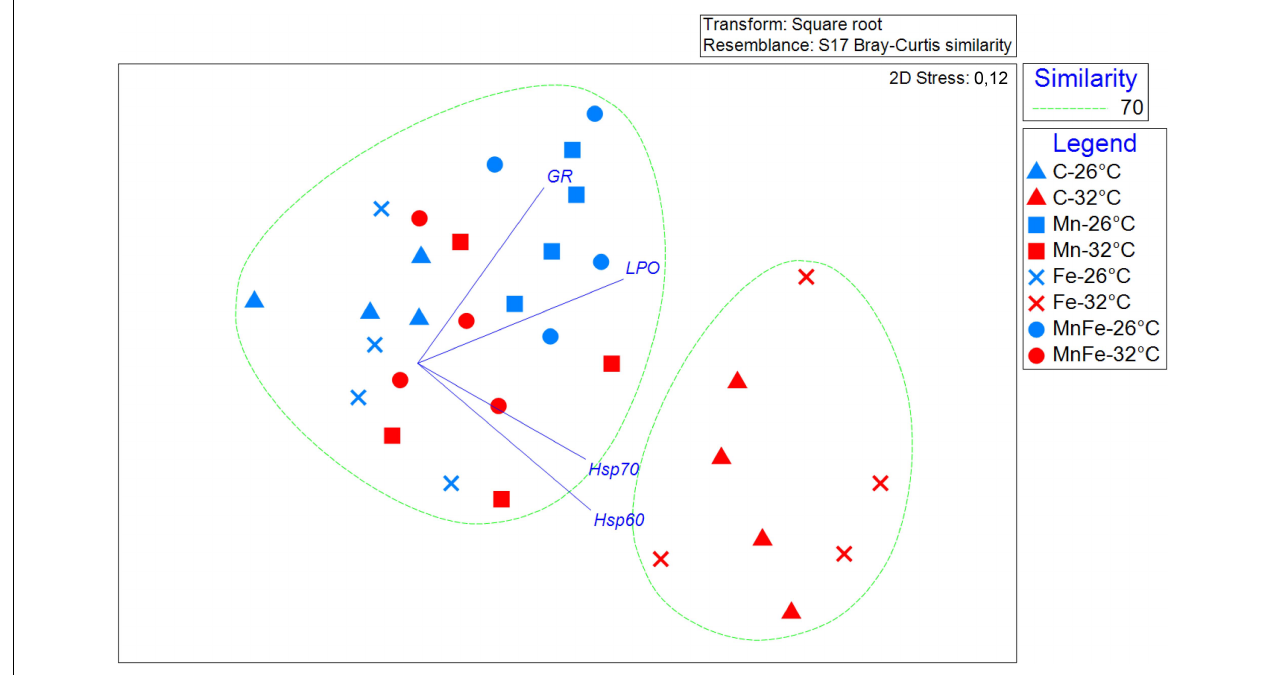
FIGURE 4 | Non-metric multidimensional scaling plot (nMDS) showing the response pattern of all the S. pistillata biomarkers analyzed by metal treatment and different temperatures, with vectors (Pearson’s correlations ≥ 0.8) representing the variables (biomarkers) that drive significant similarities among experimental